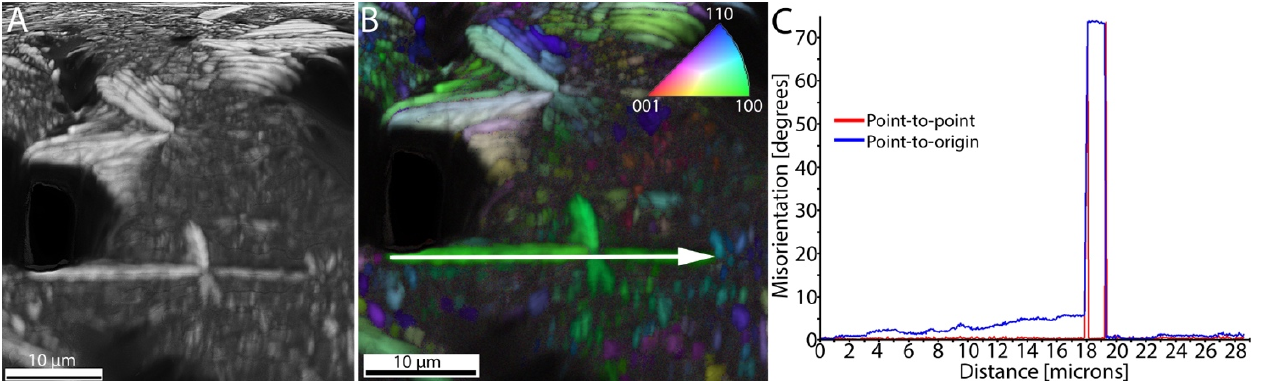
Figure 12. High-resolution EBSD data of a sample heat-treated in vacuum. ( A ) Image quality. ( B ) 001 inverse pole figure mapping with indicated profile line. ( C ) Misorientation profile along the profile line.